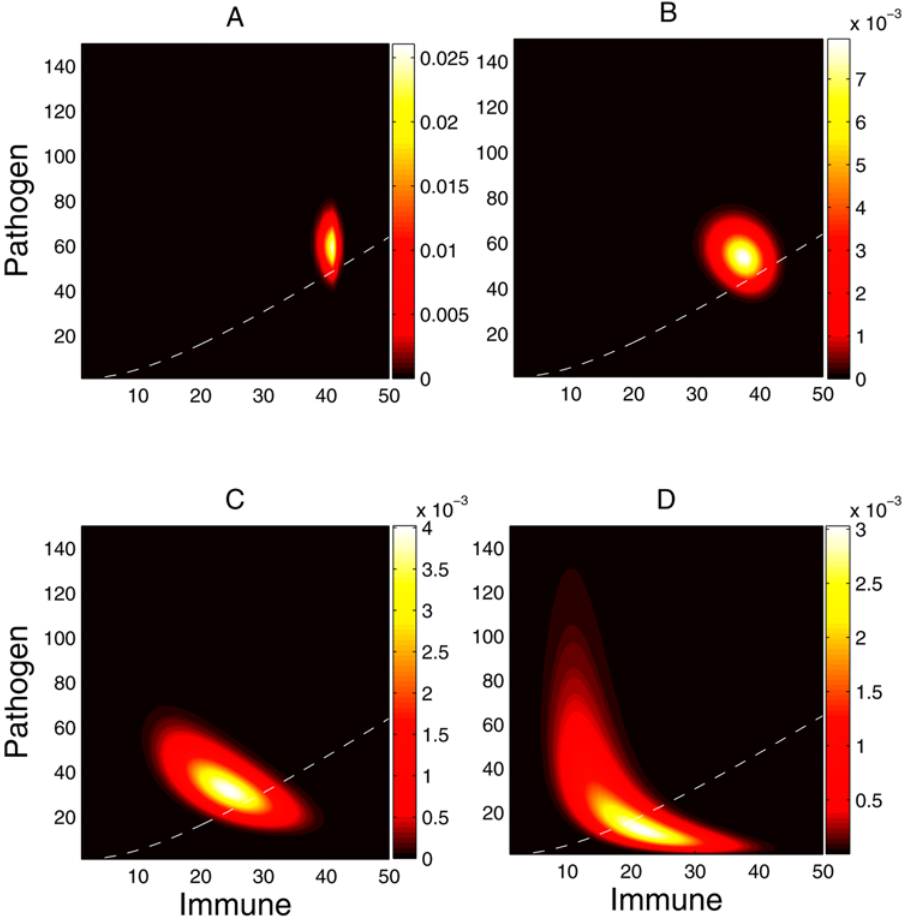
Figure 2. State probability distribution at the end of inoculation ( t ~ T e ) for a dose of D e ~ 60 and temporal exposure length of T e ~ A ) 0.1 h, B) 1.0 h, C) 10.0 h and D) 50.0 h. The distribution of probabilities if T e ~ 0 would be I , P ð Þ ~ 40, 60 ð Þ given the parameters of the system are h P , d P , a I , c I , d I , l I f g ~ 0 : 15, 0 : 01, 0 : 4, 0 : 01, 0 : 005, 0 : 05 f g . The dashed white line is the separatrix of the deterministic version of the model (see subsection Deterministic Analysis); if the system were deterministic once inoculation has been completed, the states that fall below the separatrix would end up in no infection, and the states above would end up in infection. states. Figure 2 shows the stochastically determined distribution of system states at the point in Figure 1 where the exposure time has just ended. It illustrates the effect of different temporal exposure lengths, ranging from T e ~ 0 : 1 (six minutes) to T e = 50 hours. Panel B shows this point of time for the settings in Figure 1. The